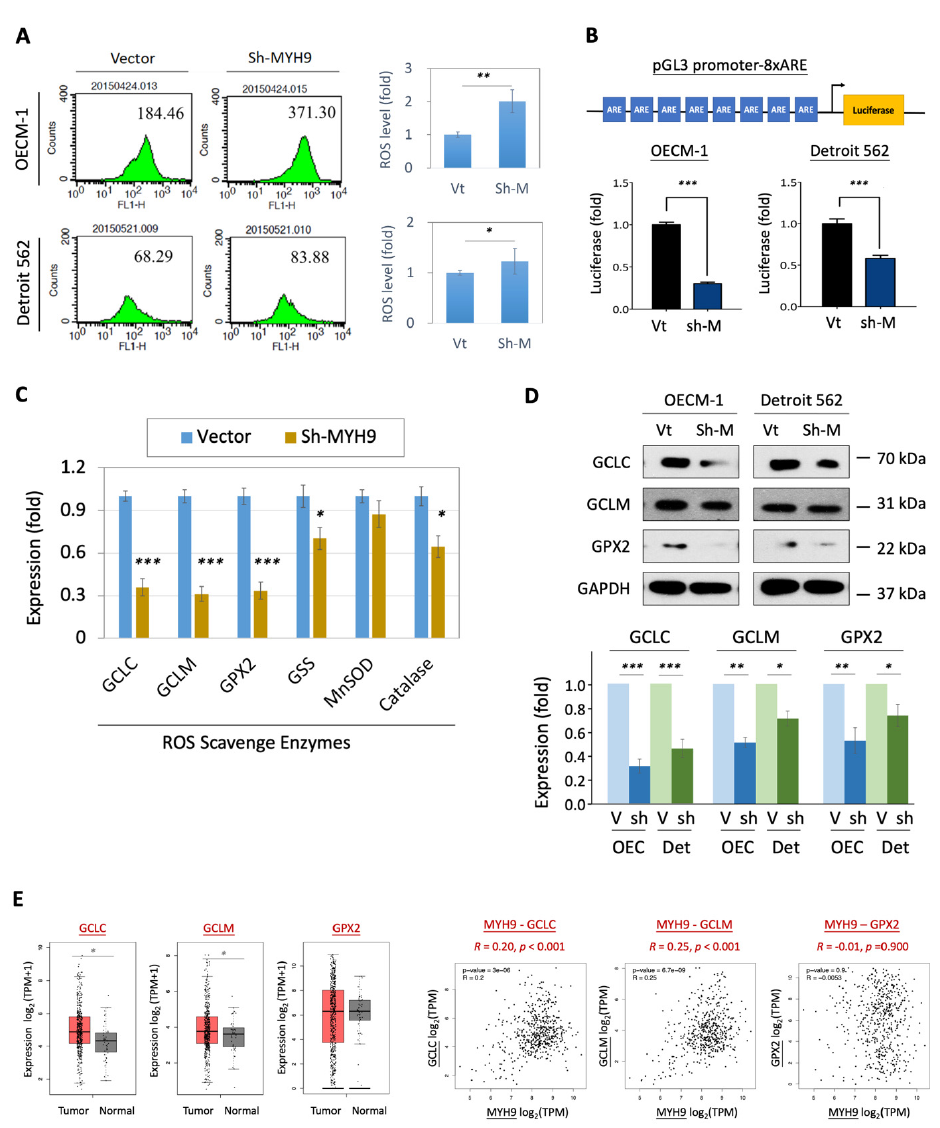
Figure 3. MYH9 modulated intracellular ROS level leads to radioresistance in HNC cells. ( A ) MYH9 silencing increased ROS production in HNC cells. After transfection of MYH9-shRNA plasmids in theboth HNC cells (OECM-1 and Detroit 562), the ROS level was determined using the H2DCF-DA oxidation method and analyzed by flow cytometry. ( B ) MYH9 silencing reduced the Nrf2 transcriptional activity. Upper: A schematic representation of the pGL3 promoter-8xARE construct which was identified for measuring Nrf2 transcriptional activity. Lower: A luciferase report assay was used to compare the relative level of Nrf2 transcriptional activity in the HNC cells (OECM-1 and Detroit 562) transfected with MYH9-shRNA (sh-M) versus control transfectant (Vt). ( C , D ) MYH9 silencing inhibited the expression of ROS scavenger enzymes at the mRNA level of the OECM1 cells ( C ) and the protein ( D ) levels in two HNC cell lines. ( E ) Significantly higher expressions of ROS scavenger enzymes (GCLC, and GCLM) in HNC tumor samples compared to the normal samples. Correlative expressions between MYH9 and ROS scavenger enzymes-associated molecules GCLC and GCLM, in the HNC tumor samples. The gene expression data were retrieved from the TCGA-HNSC dataset. All the experiments were performed at least three times independently, and a typical result was shown. The error bars shown in the relevant figures indicate the standard deviation of the quantification results in all experiments. (*: p < 0.05, **: p < 0.01, ***: p < 0.001, t